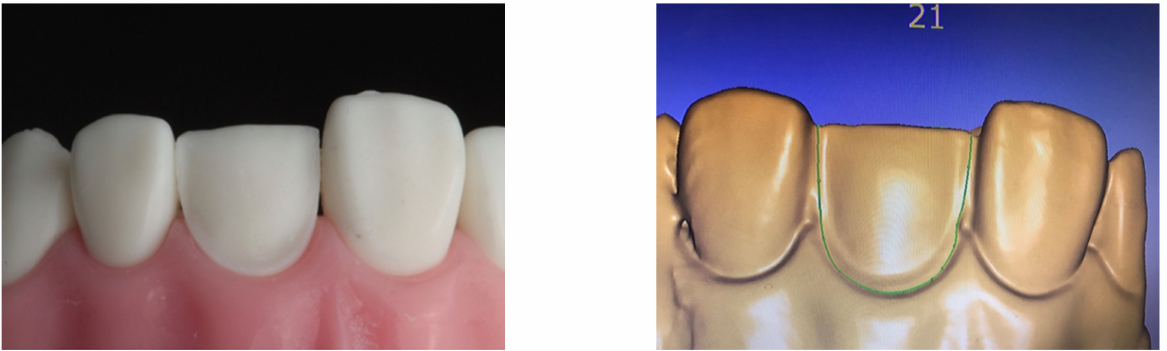
Figure 1. Veneer preparation on Ivorine typodont model and the corresponding digital